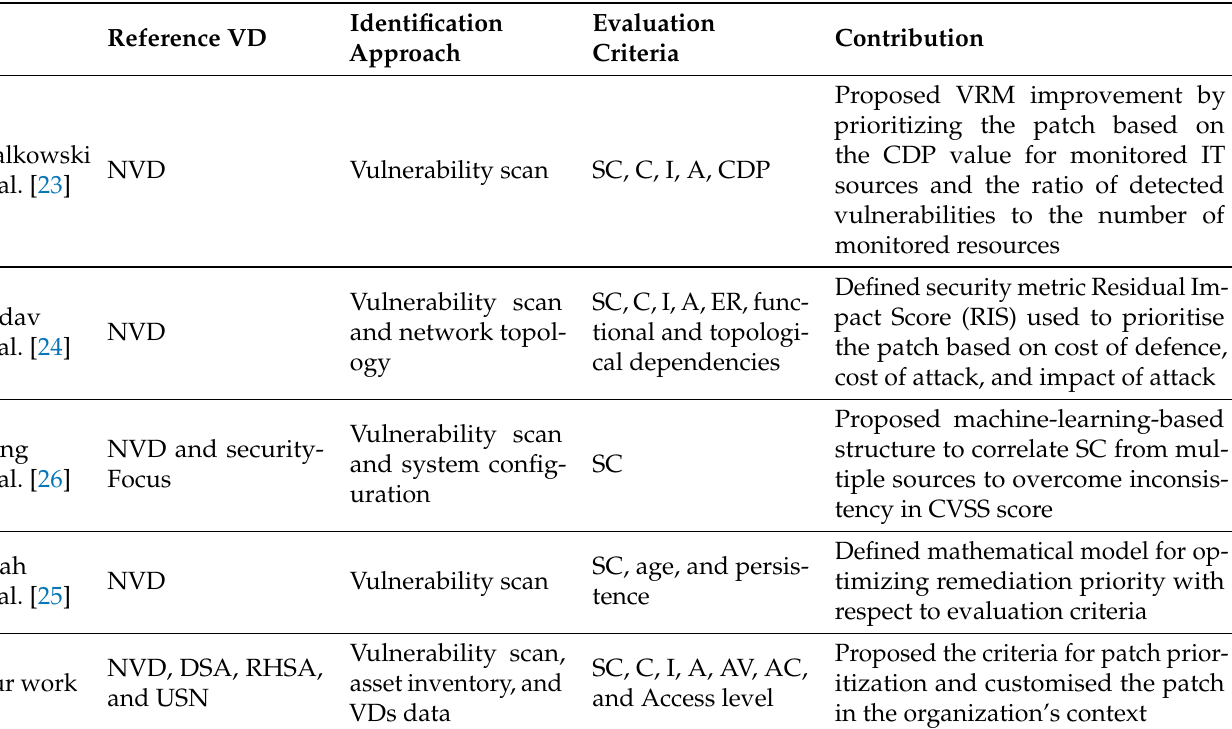
Table 1. Comparison of our approach to most recent related work. For acronyms, cf. Section 5 and the Abbreviations